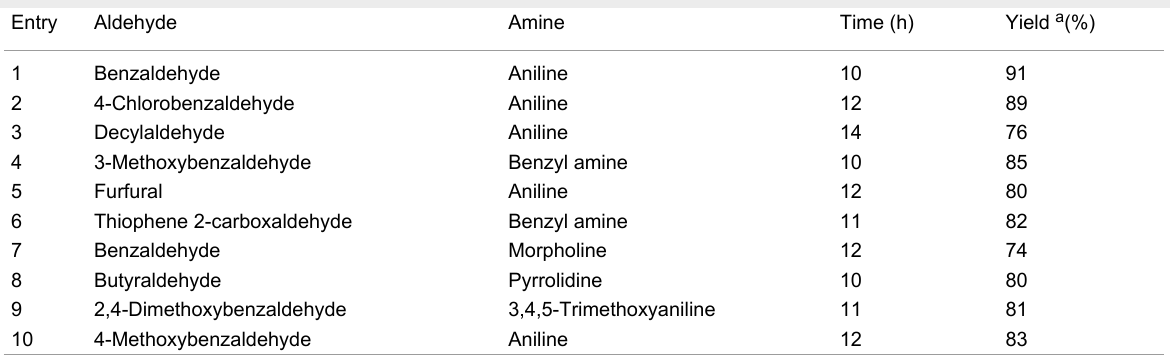
Table 1: Cobalt (II) chloride- catalyzed synthesis of α-amino nitriles with potassium